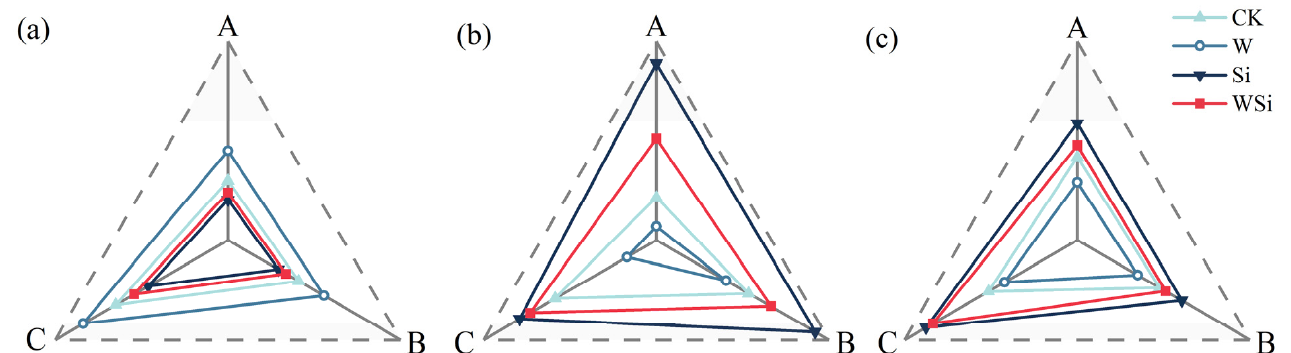
7 of 17 Figure 4. Synergistic e ff ects of water management and silicon foliar spraying on rice photosynthesis (( a ) net photosynthetic rate (Pn); ( b ) stomatal conductance (Gs); ( c ) transpiration rate (Tr); ( d ) inter- cellular CO 2 concentration (Ci)). The error bar represents three repeated standard deviations (SDs). There is no signi fi cant di ff erence between values with the same le tt ers in the table ( p ≥ 0.05, Fisher’s LSD test). A, B and C represent the actual measured Cd content in soil after the addition of exoge- nous Cd at 0.20 mg·kg − 1 , 0.60 mg·kg − 1 and 1.60 mg·kg − 1 , respectively. 2.5. Synergistic E ff ects of Water Management and Silicon Foliar Spraying on MDA, SOD and POD Content in Rice Leaves The synergistic e ff ects of water management and silicon foliar spraying on malondialdehyde (MDA), superoxide dismutase (SOD) and peroxidase (POD) content in rice leaves are shown in Figure 5. There was a gradual increase in MDA and a gradual decrease in SOD and POD. At the three Cd concentrations, compared to the CK treatment,